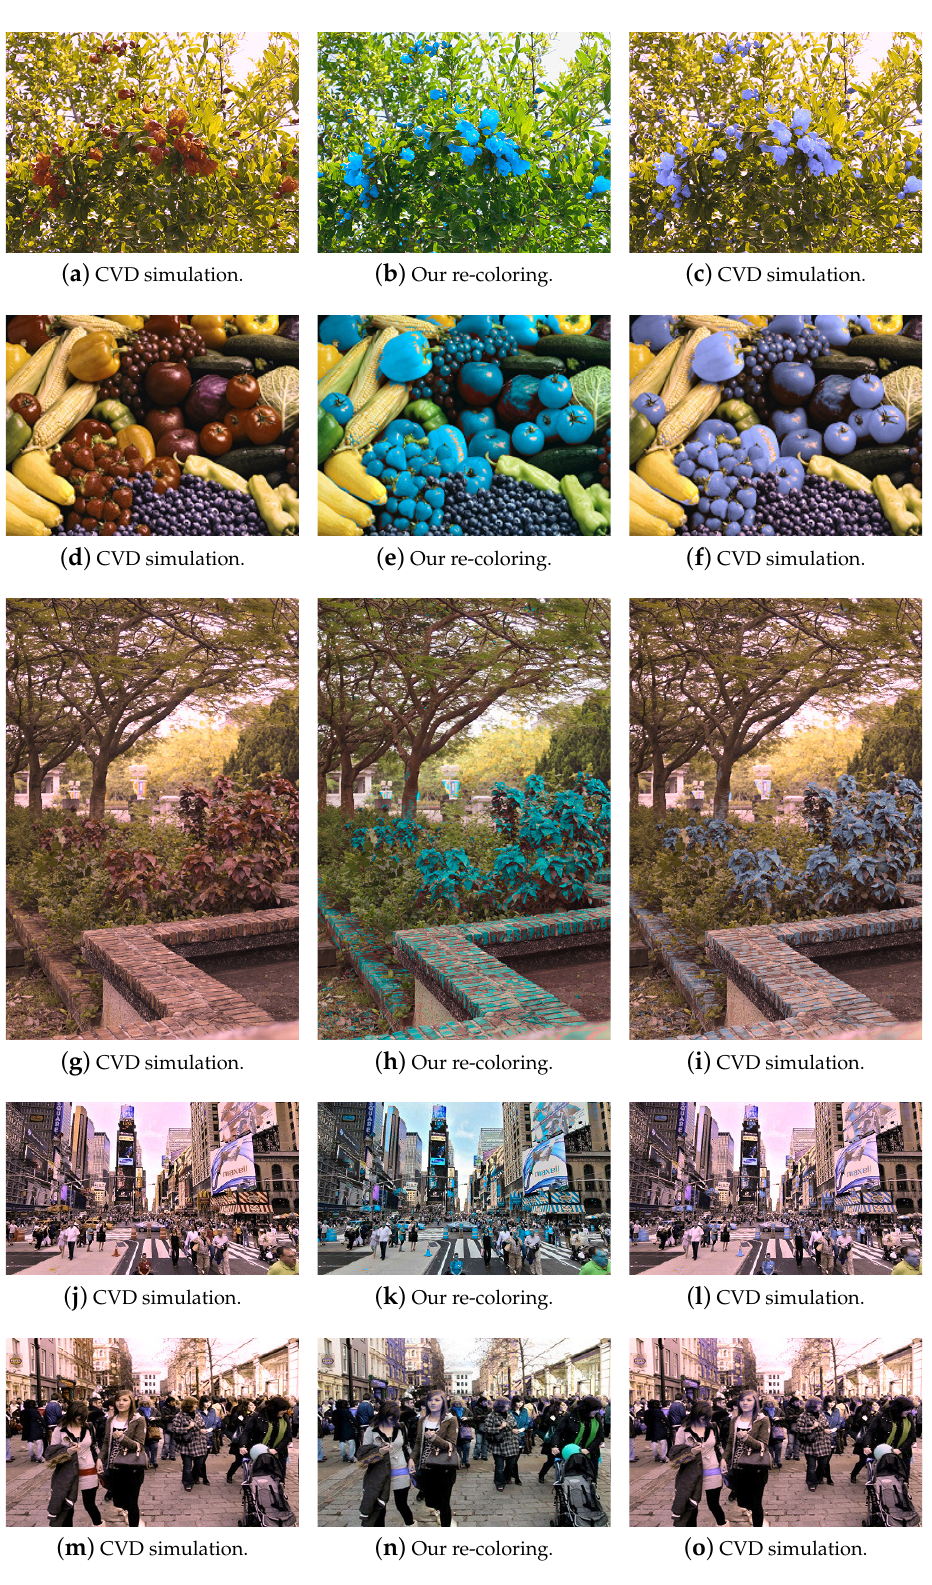
Figure 15. The results of CVD simulation, re-coloring using the proposed technique and CVD simulation on the re-colored images for some test images in Figure 10 (the first two columns) and 15 (the third